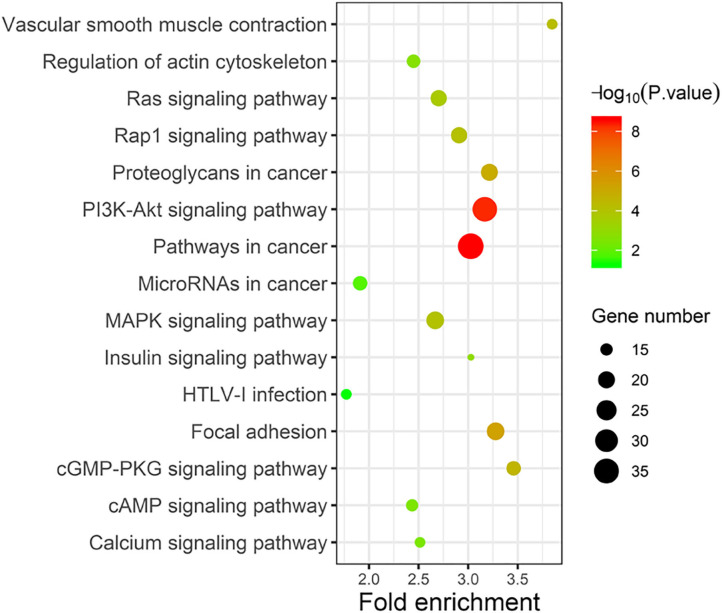
KEGG analysis of the 28 validated genes.